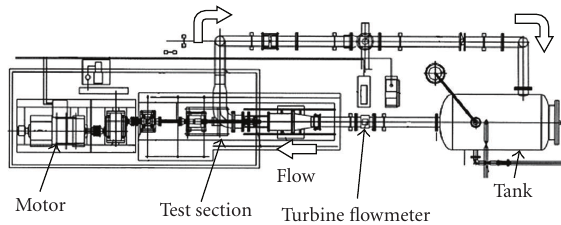
Figure 1: Inducer test facility of IHI.